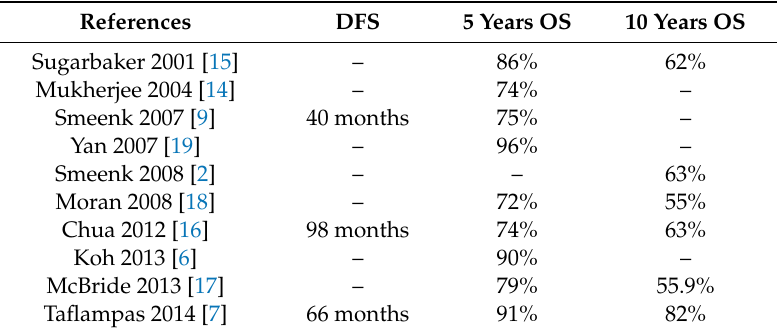
Table 1. Clinical outcome of appendiceal PMP treated with CRS +